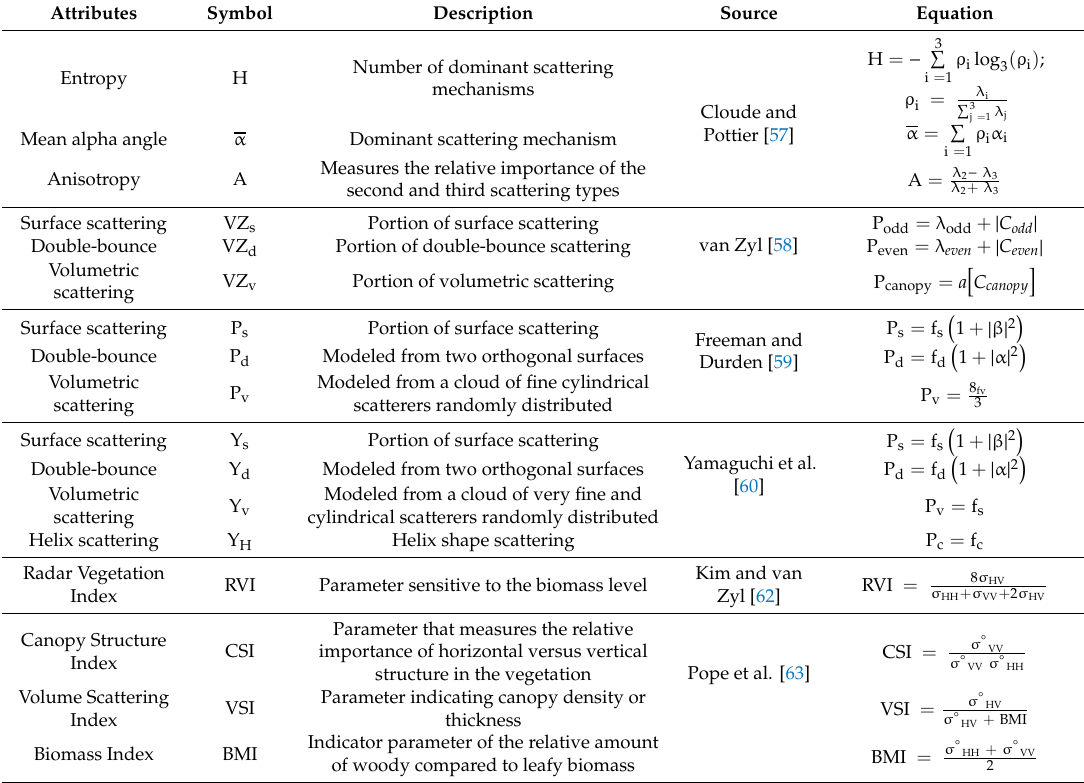
Table 3. Attributes extracted from the ALOS / PALSAR-2 polarimetric